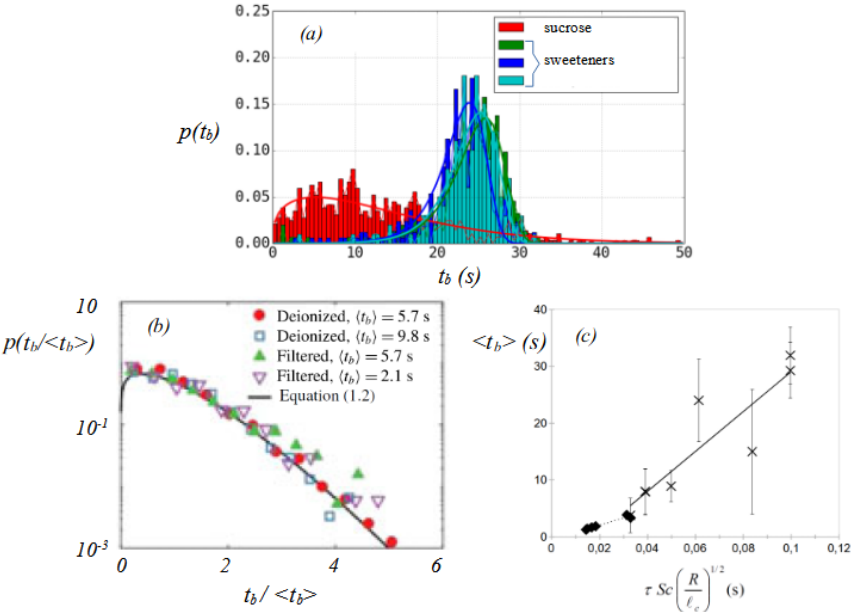
Figure 7. ( a ) Probability density function of lifetimes of bubbles at the surface of aqueous solutions of sucrose and sweeteners, extracted with authorization from Miguet et al. [52]. ( b ) Normalized probability density function of lifetimes of bubbles at the surface of water baths of different quality, extracted with authorization from Poulain et al. [45]. ( c ) Average lifetime of bubbles as a functions of τ Sc ( R / l c ) 1/2 at the surface of ethanol-water mixture (each × corresponds to a different % of ethanol in water) extracted from Lorenceau et al. [59] and at the surface of sea water (each (cid:5) corresponds to a different bubble size) extracted with authorization from Zheng et al.